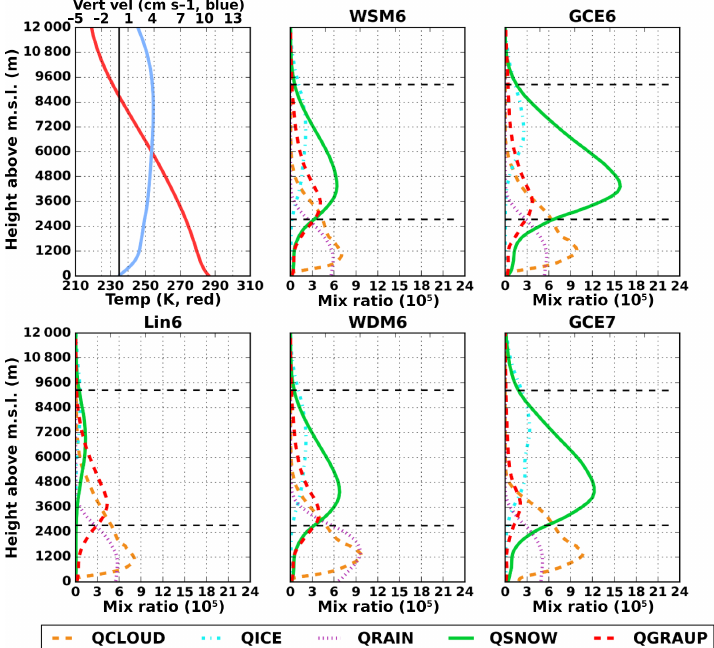
Figure 5. Domain 4 averaged (1.167km grid spacing), composite mixing ratios (kgkg − 1 ) , temperature (K), and vertical velocities (cms − 1 ) composited over all seven nor’easter events. The black dashed lines denote the height above mean sea level (MSL) where the air temperature is 0 or − 40 ◦ C. The upper-left panel shows composited and model-averaged profiles of temperature (red line) and vertical velocity (blue). Mixing ratio species abbreviations are QCLOUD (cloud water), QGRAUP (graupel), QICE (cloud ice), QRAIN (rain), QSNOW (snow), and QHAIL